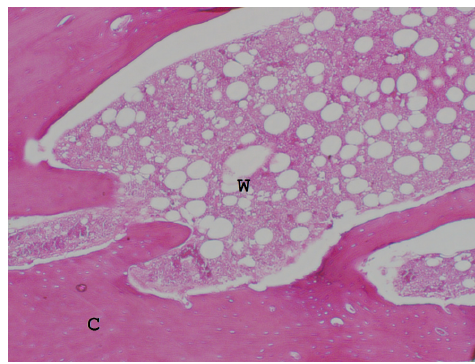
Figure 6. The histology of the callus showed a mixture of cortical bone (C) and woven bone (W).